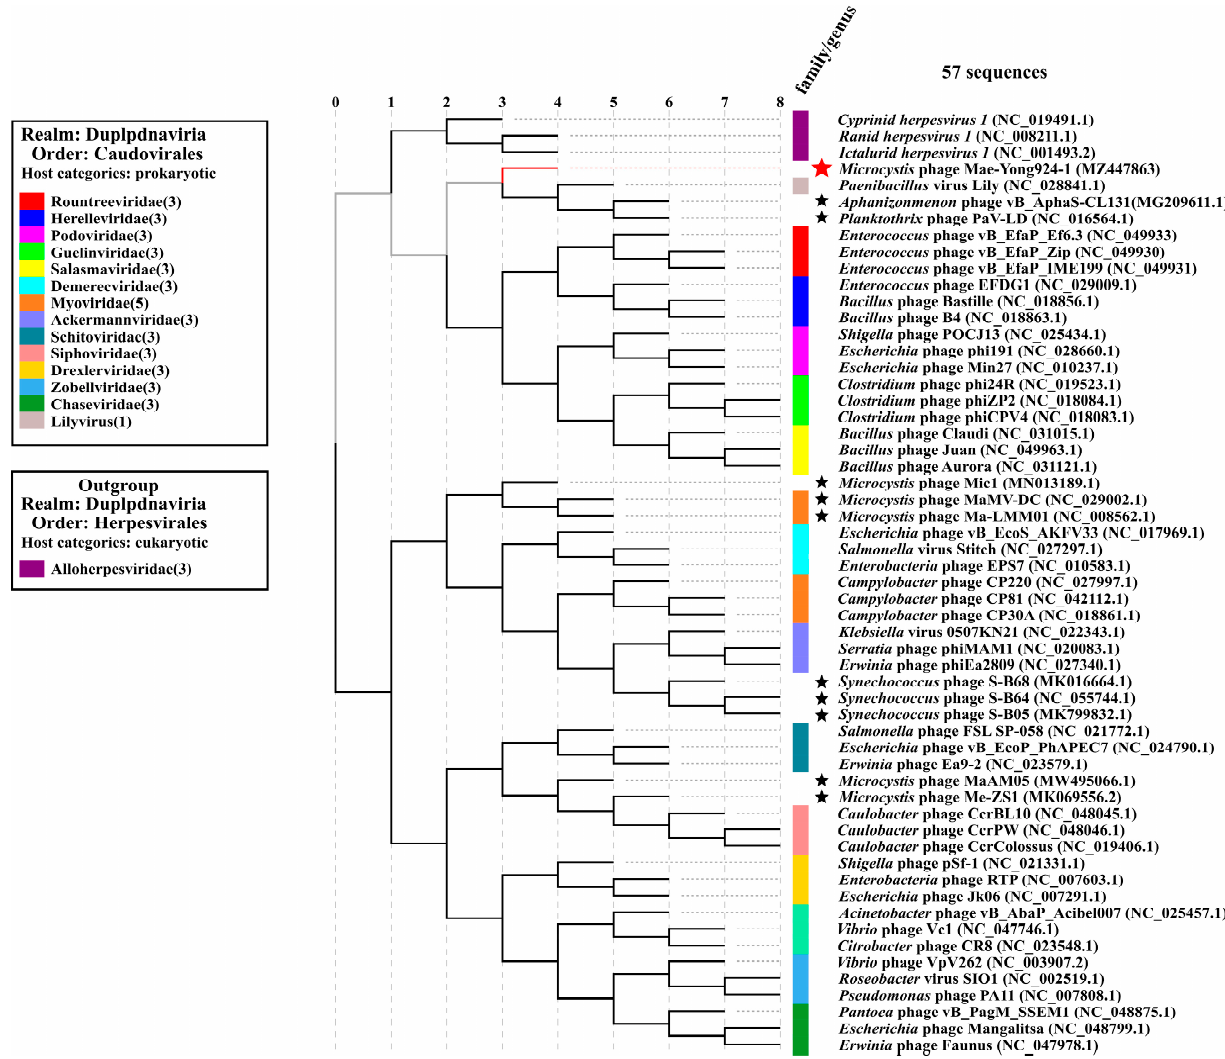
Figure 4. Proteomic tree based on the complete genome sequences of Mae-Yong924-1 (red star), 10 other cyanophages (black star) including 5 Microcystis cyanophages, 43 representative bacterio- phages of Caudovirales and 3 viruses of Herpesvirales